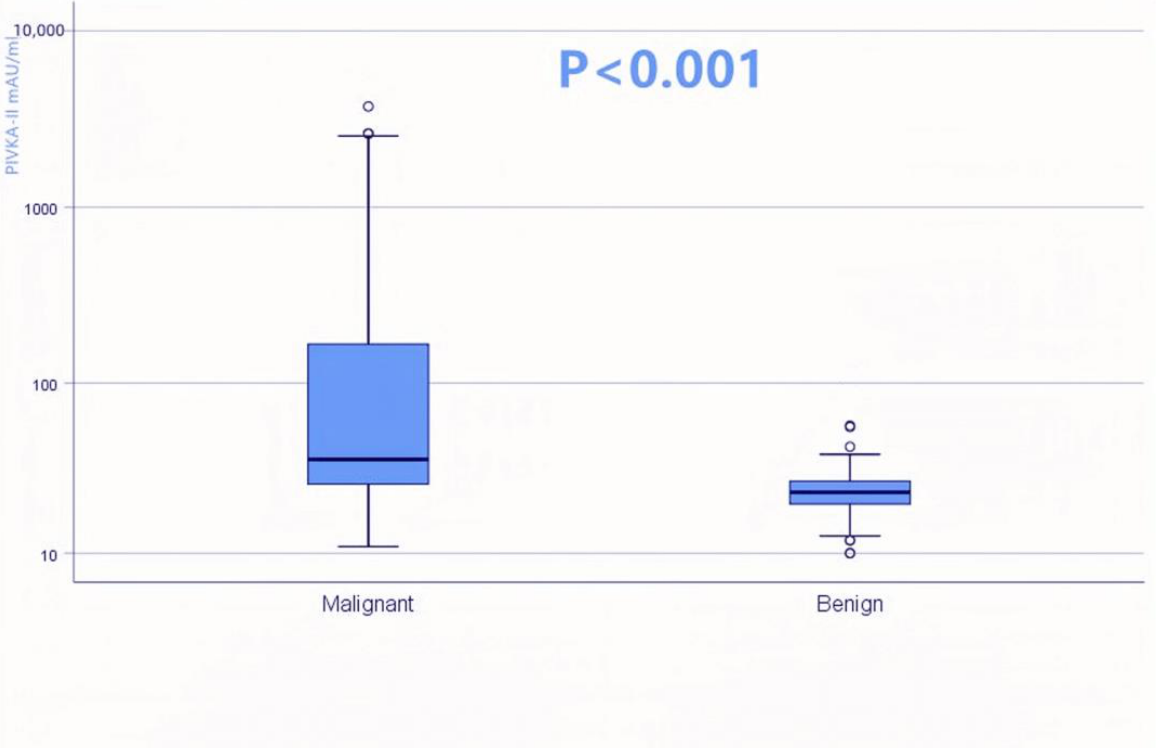
Figure 2. A comparison of serum protein induced by vitamin K absence-II (PIVKA-II) levels in patients with pancreatic ductal adenocarcinoma and benign lesions.